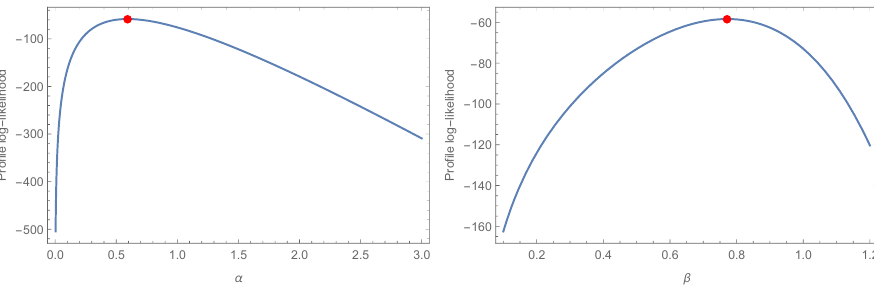
Figure 5. The log-likelihood function plots for parameters α and β